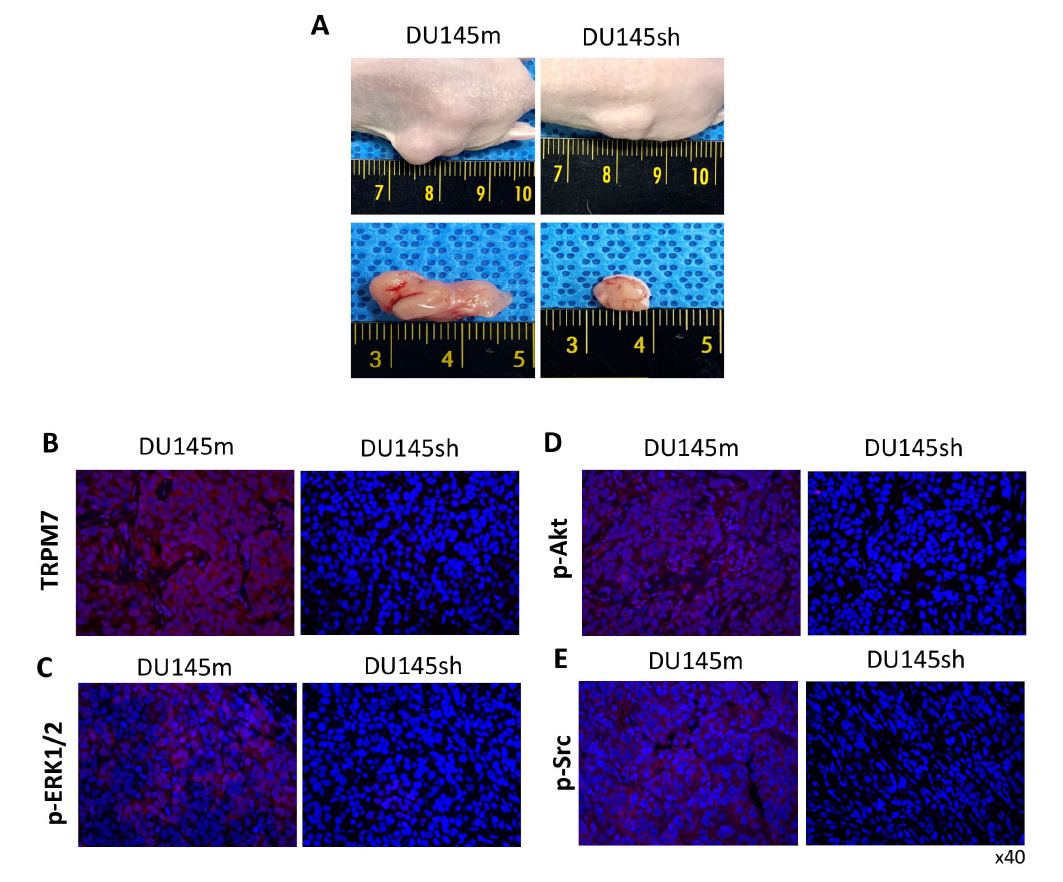
Fig. 5. Knockdown of TRPM7 suppressed prostate cancer cell growth in xenograft model. (A) Representative image of mice and tumor gross. Representative images of TRPM7 (B), p-ERK1/2 (C), p-Akt (D) and p-Src (E) of DU145m and DU145sh injected tumor (n = 4). Magnification: × 40.